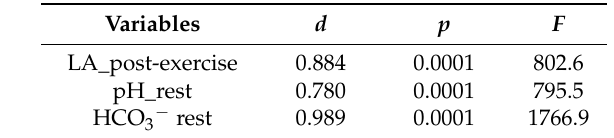
Table 1. Statistically significant differences between the experimental and control groups at baseline and after bi-carbonate and mineral supplementation at rest and after exercise.